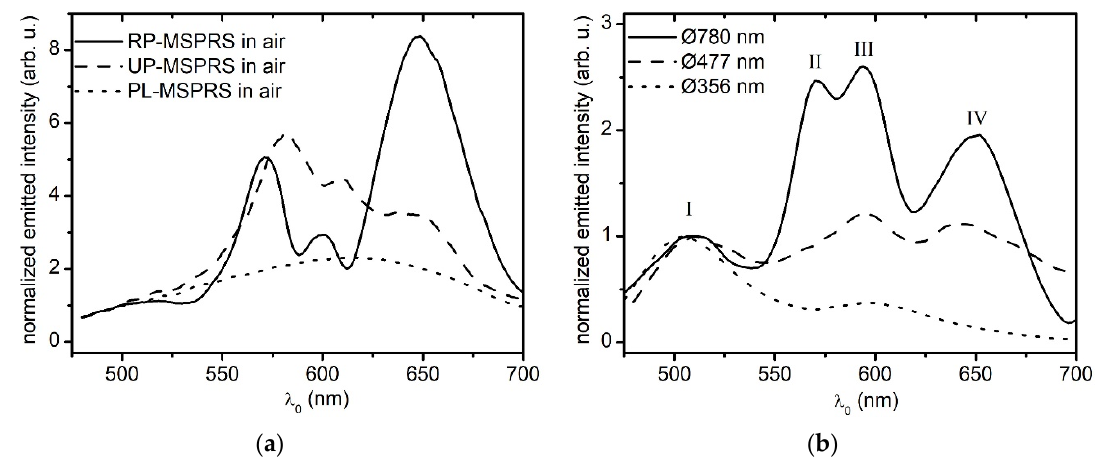
Figure 5. ( a ) MSPRS resonances displaying spectral lines with resolved peaks ( continuous line ), with un-resolved peaks ( dash line ) and peak-less ( dotted line ) profiles; ( b ) Spectral resonances of MSPRSs with different core diameters: ( continuous line ) three peaks for the 780-nm diameter; ( dash line ) two peaks for the 477-nm diameter, and ( dotted line ) one peak for the 356-nm core; For comparison, all spectra were normalized in intensity at 500 nm. To avoid clutter, only the continuous line spectrum in ( b ) had the peaks labeled with roman numbers (increasing from left to right), but the rule applied to all spectral profiles.